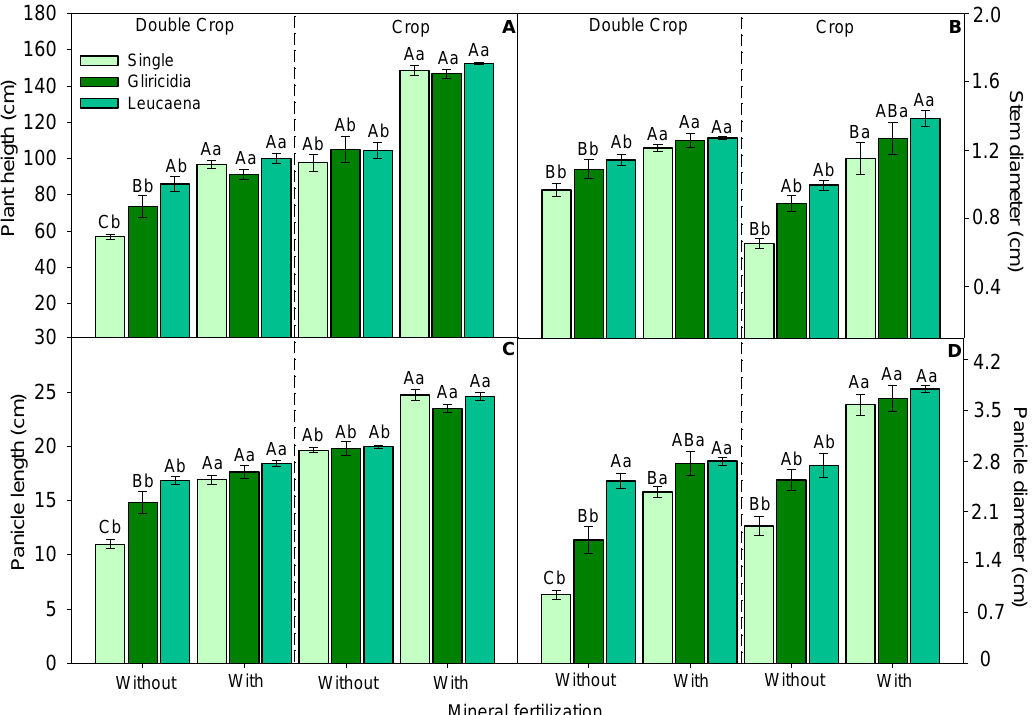
Figure 3. Plant height ( A ), stern diameter ( B ), panicle length ( C ) and panicle diameter ( D ) of forage sorghum submitted to the combination of leguminous alleys and mineral fertilization. Averages followed by the same lowercase letter for fertilization and uppercase letter for cropping systems were found by the Tukey test to not differ from each other at 5%.